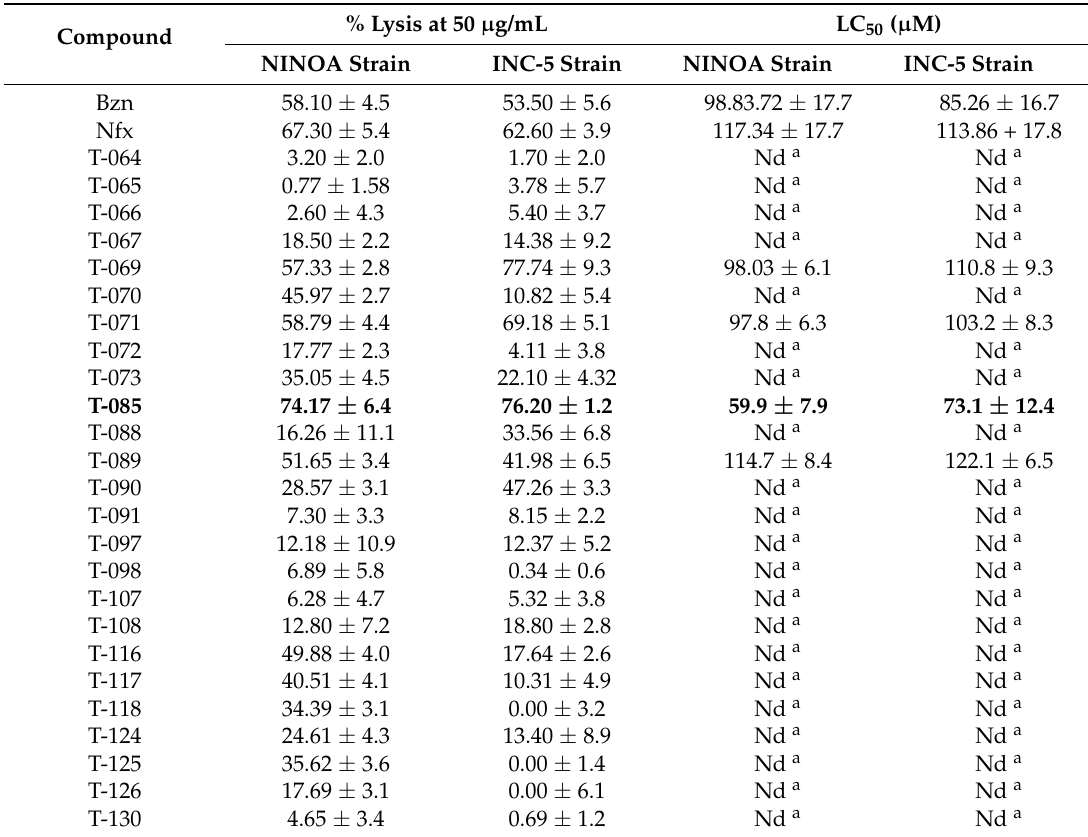
Table 2. Biological activity of quinoxaline 1,4-di- N -oxide on T. cruzi